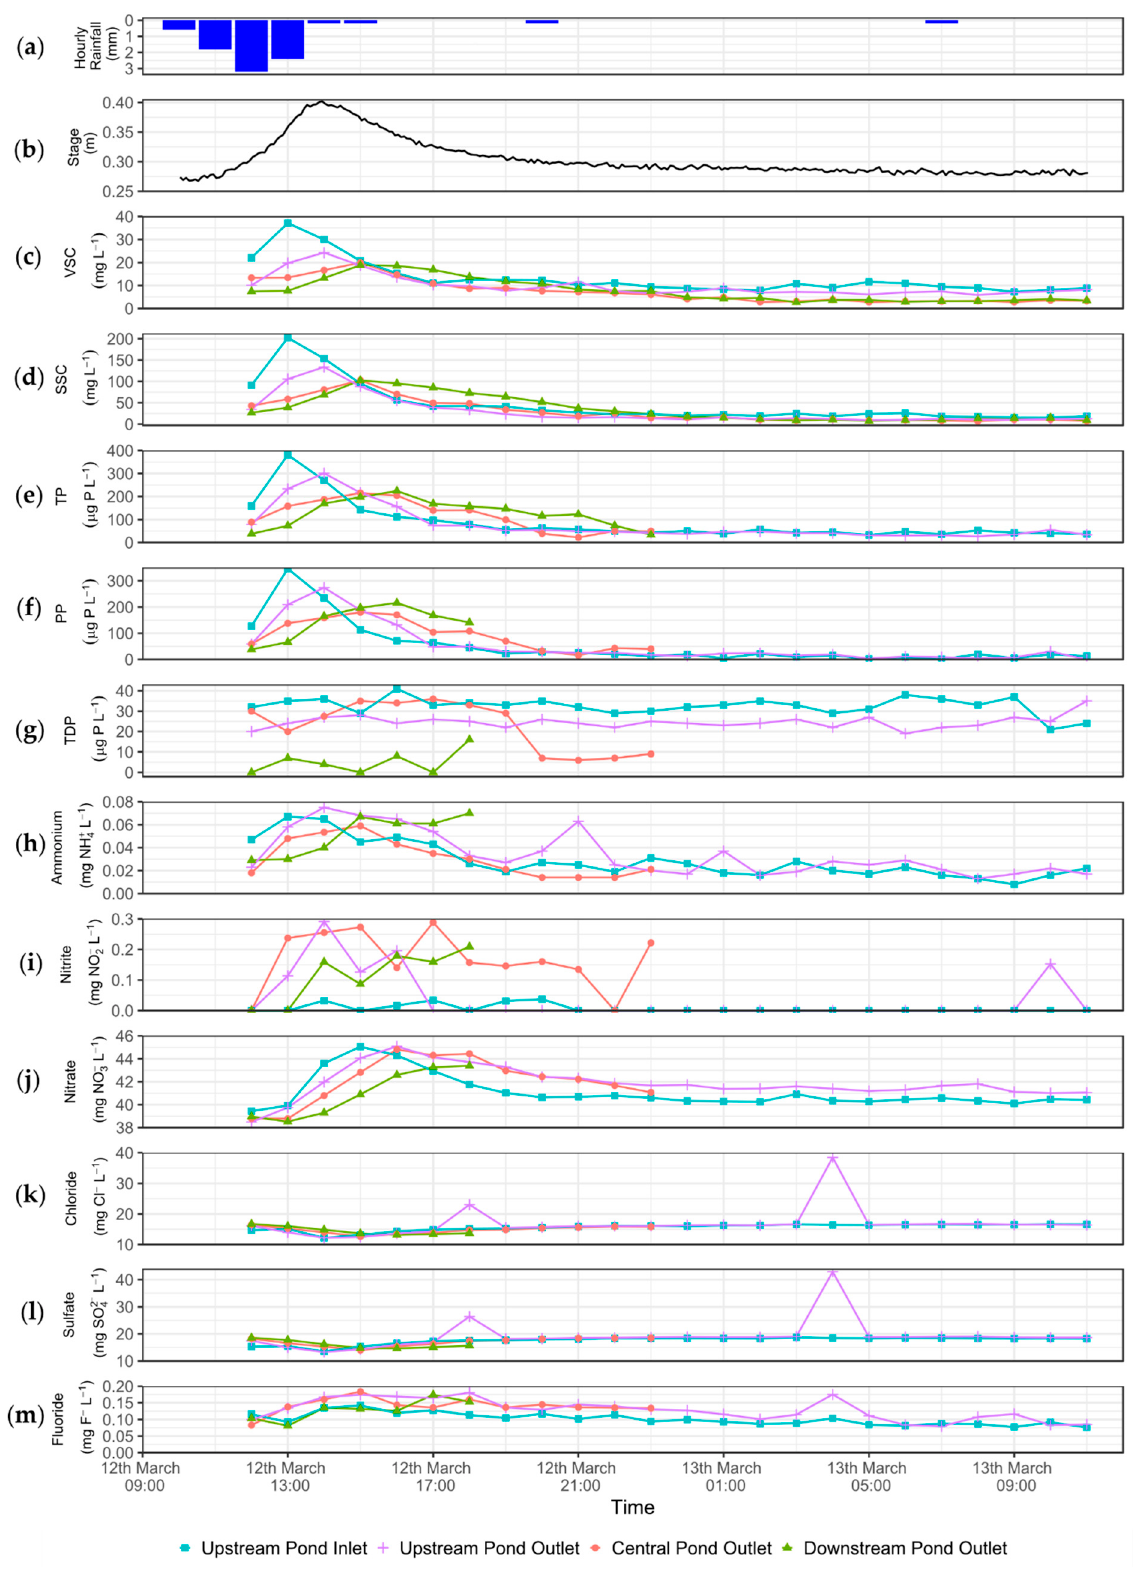
Figure 4. Timeseries during a storm event on 12/13 March 2019 showing: ( a ) hourly rainfall (mm); ( b ) stage (m) in the Central Pond; and concentrations of water quality determinands: ( c ) VSC and ( d ) SSC (mg L − 1 ); ( e ) TP, ( f ) PP, and ( g ) TDP ( μ g P L − 1 ); ( h ) ammonium (mg NH 4+ L − 1 ); ( i ) Nitrite (mg NO 2 − L − 1 ); ( j ) Nitrate (mg NO 3 − L − 1 ); ( k ) chloride (mg Cl − L − 1 ); ( l ) Sulfate (mg SO 42 − L − 1 ) and ( m ) Fluoride (mg F − L − 1 ) at each pond inlet/outlet sampling site.